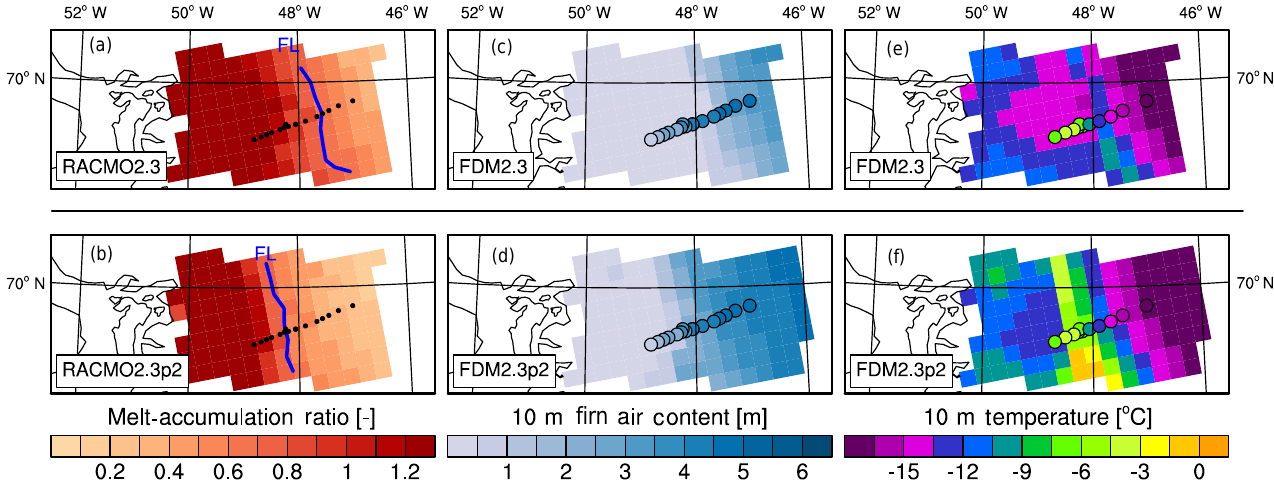
Figure 2. Evaluation of simulated firn air content and 10m firn temperature with observations along a transect in the western Greenland (region indicated in Fig. 3b) percolation zone: (a–b) 1990–2009 melt-accumulation ratio ( R MA ) as simulated by RACMO2, (c–d) upper 10m firn air content as simulated by IMAU-FDM (shaded grid cells) and from firn core observation (circles, Harper et al., 2012); (e–f) average 10m firn temperature as simulated by IMAU-FDM (shaded grid cells) and from thermistor string measurements (circles, Humphrey et al., 2012). The figures in (a–b) represent RACMO2.3 and RACMO2.3p2, while (c) and (e) and (d) and (f) represent FDM2.3 and FDM2.3p2, respectively. Blue lines in (a–b) indicate the firn line (FL), chosen to be equal to R MA =0.7. Firn core observations in (c–d) are from July 2007 or May 2008 and the simulated field is an average of these two dates. Both the simulated and observed firn temperatures in (e–f) are averages over